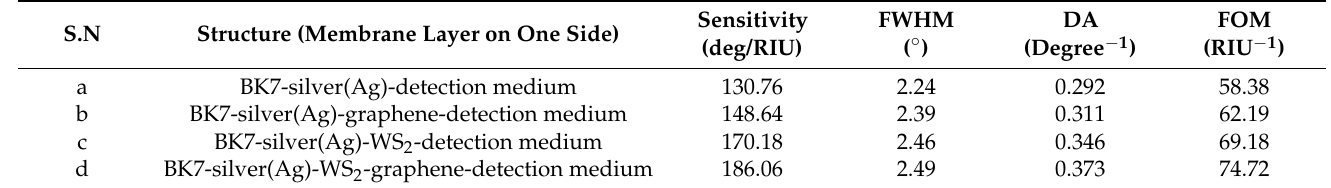
Table 2. The performance of the above four structures at a medium refractive index change gradient of 0.005 (the first decaying